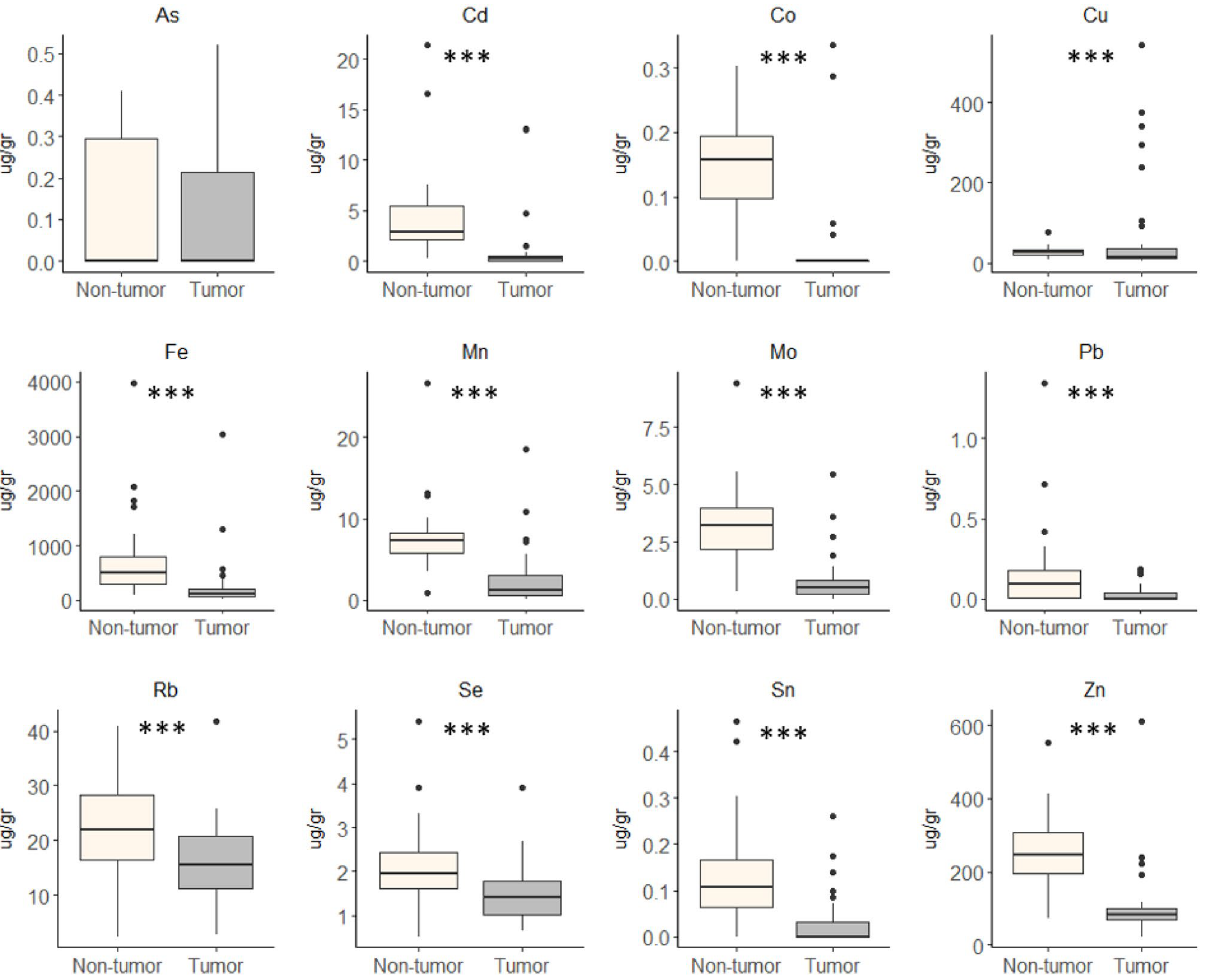
Figure 2. Comparison of metal concentration between tumoral and non-tumoral tissues in Peruvian cohort. Boxplot showing median, minimum, and maximum IQR values. Statistical test used was paired Mann–Whitney